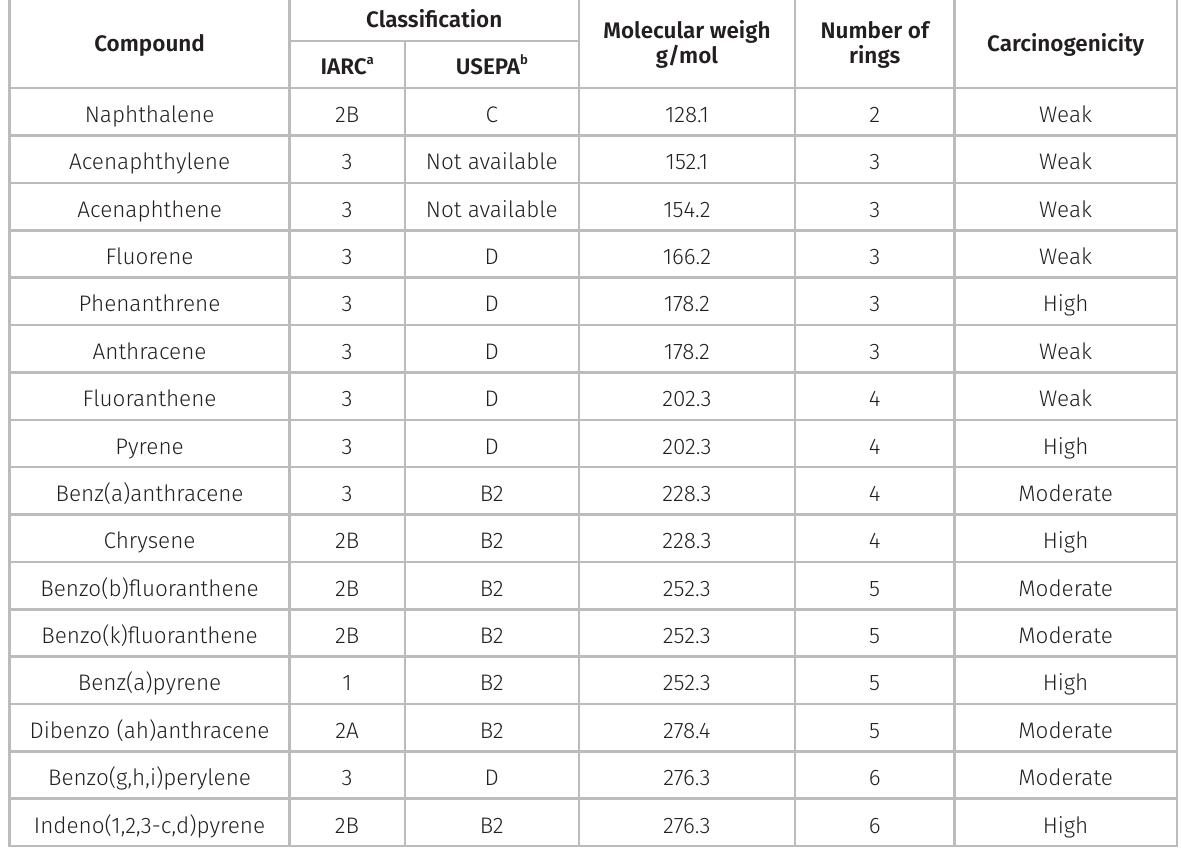
Table I. PAH classification.